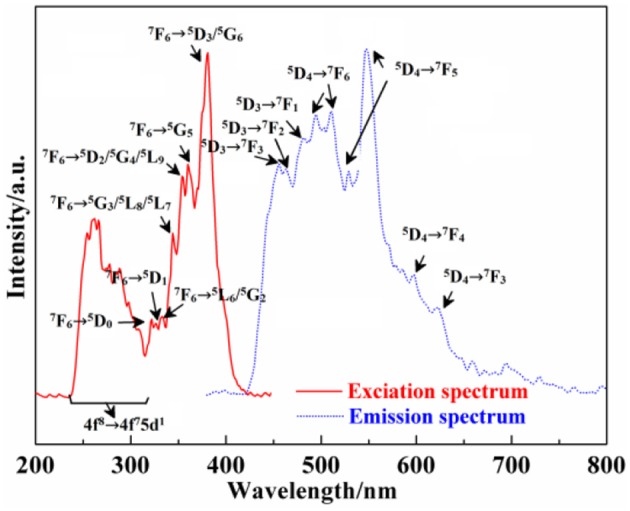
Excitation and emission spectra of Ca12Al14O33: Tb3+.